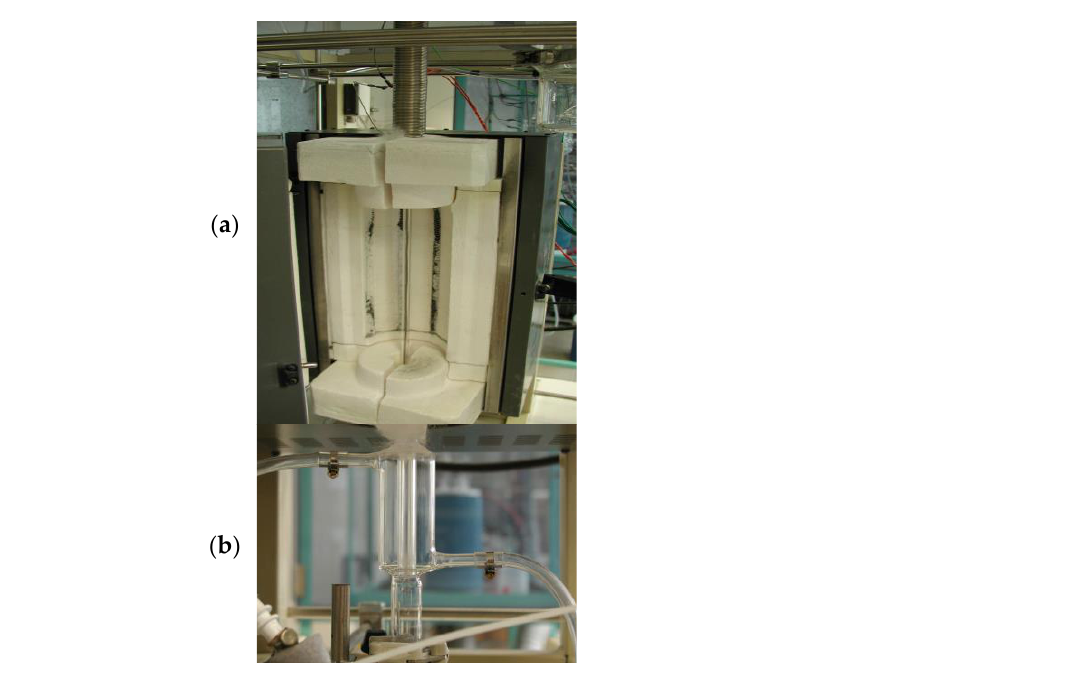
Figure 2. Photos of the designed bench-scale reaction units: ( a ) quartz tubular reactor and its furnace with upstream, the mixing/preheating unit (quartz annular exchanger surrounded by a roll of heating resistances); ( b ) quartz annular fast-quenching system (downstream the tubular reactor).